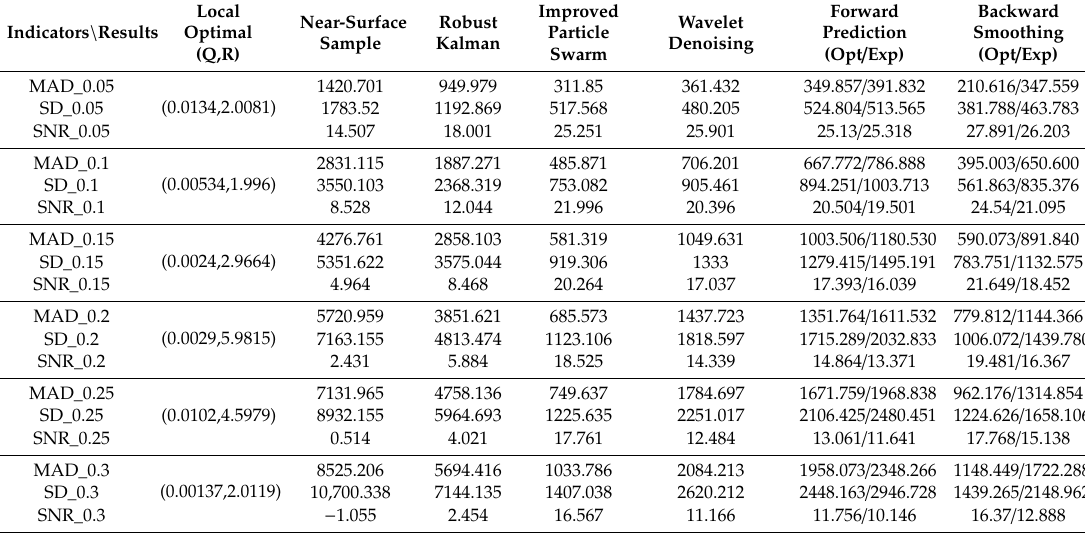
Table 2. Robust analysis of the WBKS algorithm based on multiple analysis indicators.